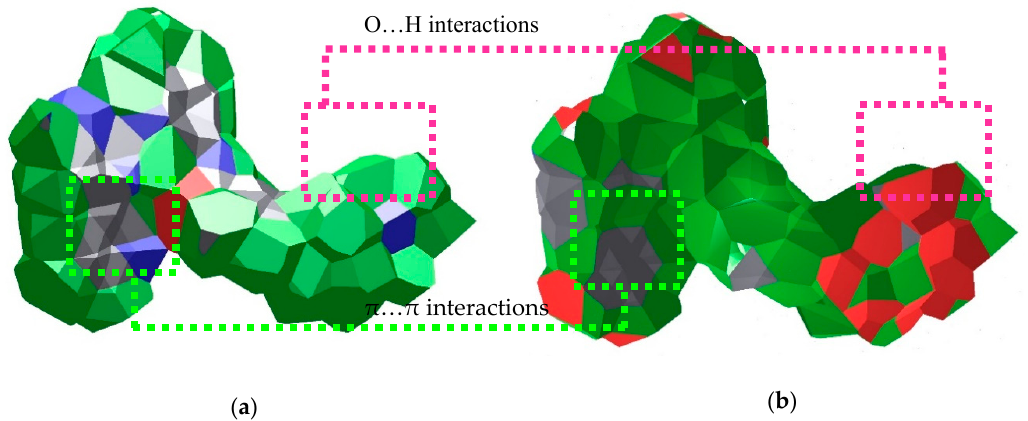
Figure 5. Molecular Voronoi polyhedron of imatinib in complex with the quinone oxidoreductase NQO2 (PDB code 3FW1 [29]) colored in accord with the nature of ( a ) inner, imatinib and ( b ) outer, receptor atoms. Color code: C-gray, H-green, N-blue, O-red. The π ... π interactions in the region of pyrid-3-yl and the O ... H interactions in the region of piperidine rings are additionally marked.